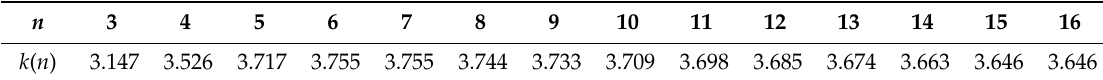
Table 2. Values of k ( n ) for n = 3, ... , 16